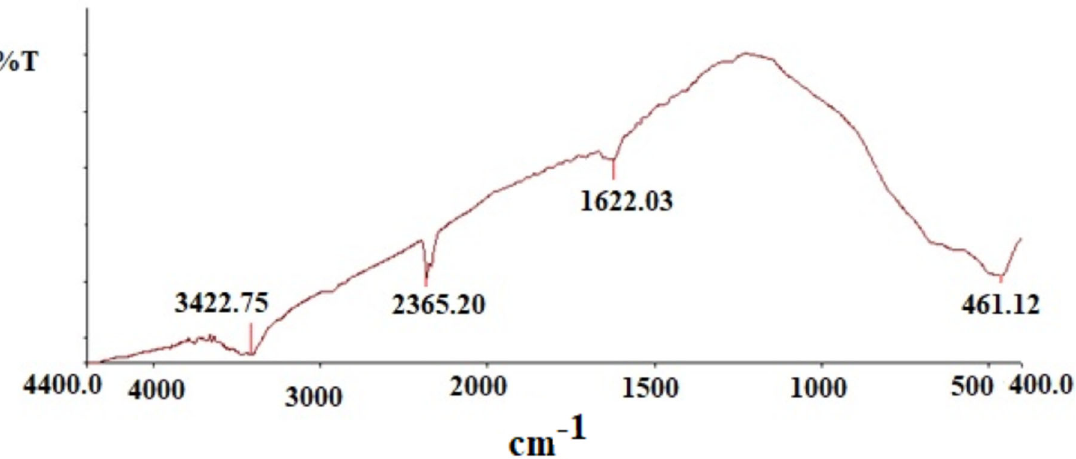
Figure 5. Fourier-transform infrared spectra of TiO 2 nanoparticles with aqueous extract of Figure 5. Fourier ‐ transform infrared spectra of TiO 2 nanoparticles with aqueous extract of Murdagoosh.